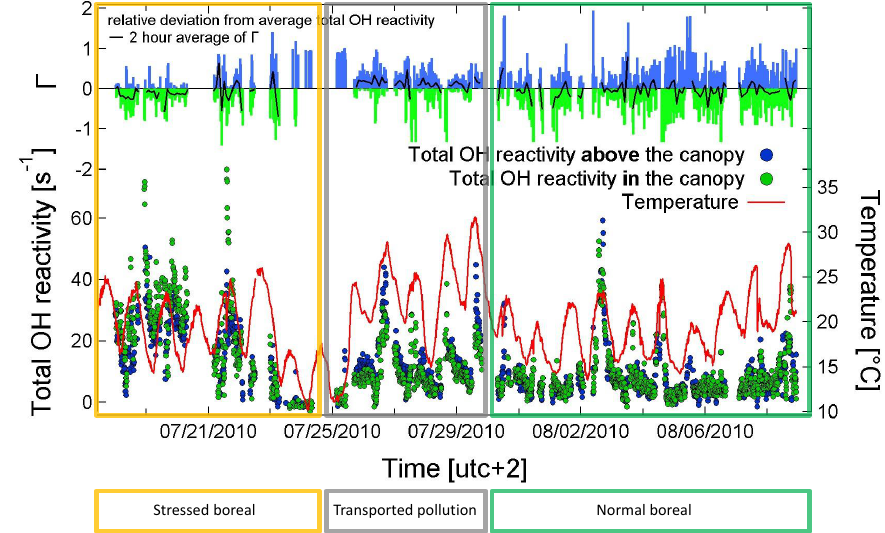
Fig. 2. Overview of total OH reactivity measurements in (green markers) and above (blue markers) the canopy, temperature (red) and superimposed (green and blue bars) the in canopy – above canopy comparison of total OH reactivity 0 . Three periods of different influences and conditions are defined, marked and